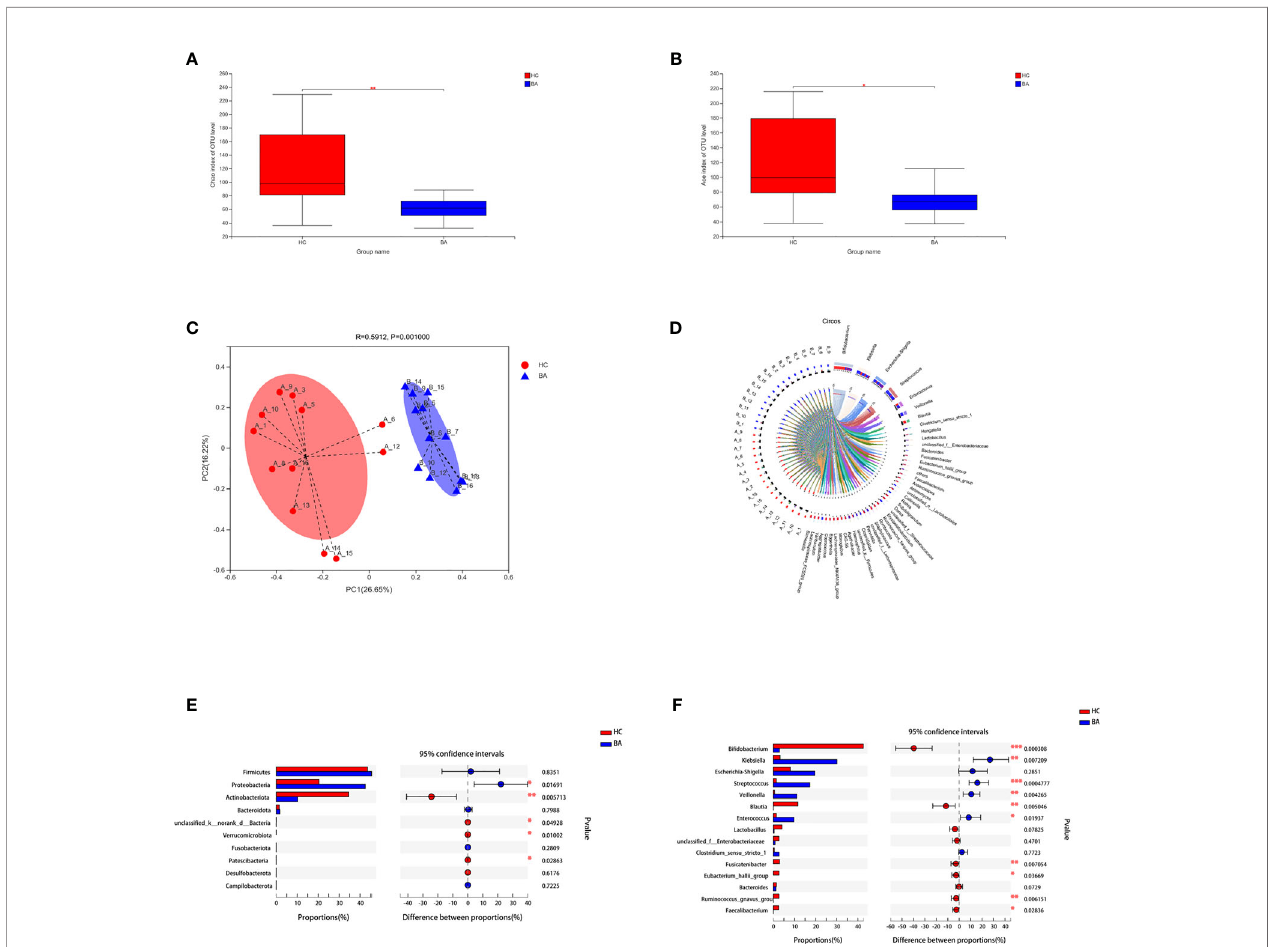
FIGURE 1 | (A, B) Community richness (Chao and ace) of gut microbiota in patients with early-stage biliary atresia and controls (BA, biliary atresia; HC, controls) (*P < 0.05, **P < 0.01). (C) Beta diversity (principal coordinates analysis based on the Bray – Curtis distance of species abundance) between the two groups (BA, biliary atresia; HC, controls). (D) Correlation between fecal microbiota structure and samples. (E, F) Microbiota with signi fi cantly different abundances at the phylum and genus level were identi fi ed (BA, biliary atresia; HC, controls) (*P < 0.05, **P < 0.01, ***P <